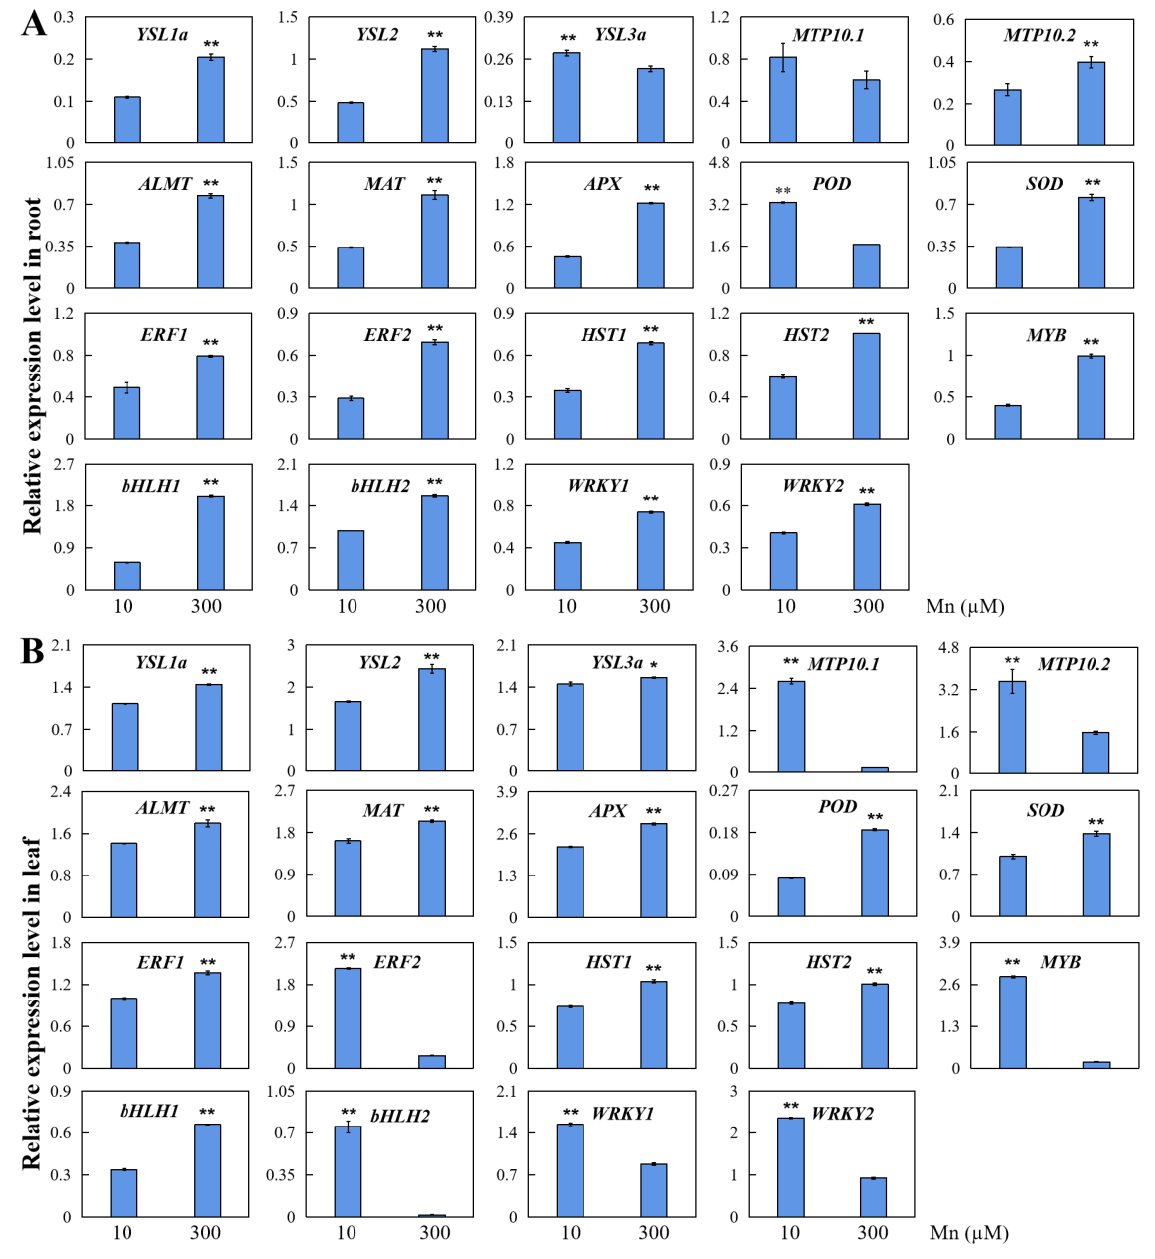
Figure 4. Results of qRT-PCR testing of 19 DEGs in peanut leaves and roots at the concentrations of 10 and 300 µ M Mn. The levels of relative expression of DEGs in ( A ) roots and ( B ) leaves. Data was represented via average value and standard deviation of four times experimental replications. Student’s t -test was used to assess the significance of the difference between the control and Mn toxicity (* p < 0.05, ** p < 0.01). YSL: yellow streak protein; MTP: metal resistance protein; ALMT: aluminum activated malate transporter protein; MAT: magnesium transporter protein; SOD: superoxide dismutase; POD: peroxidase; APX: ascorbate peroxidase; ERF: ethylene response transcription factor; HST: transcription factor of heat stress; MYB: transcription factor of MYB; bHLH: transcription factor of bHLH; WRKY: transcription factor of WRKY.